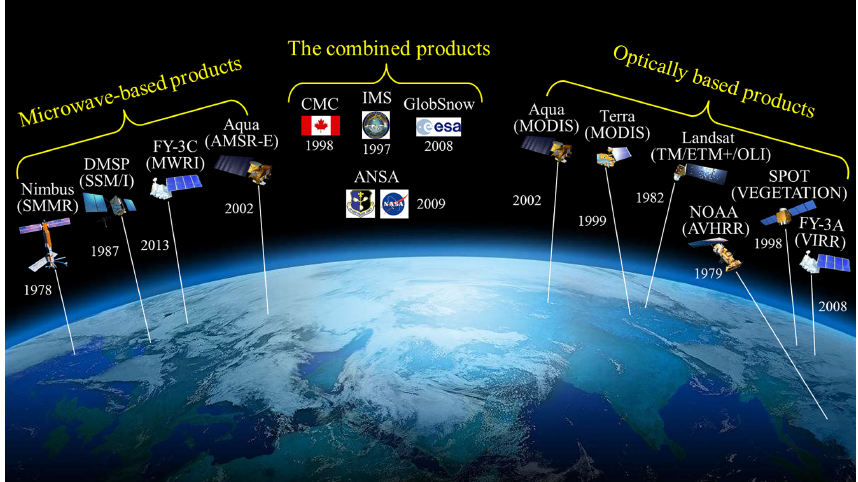
Figure 1. Snow cover products based on remote